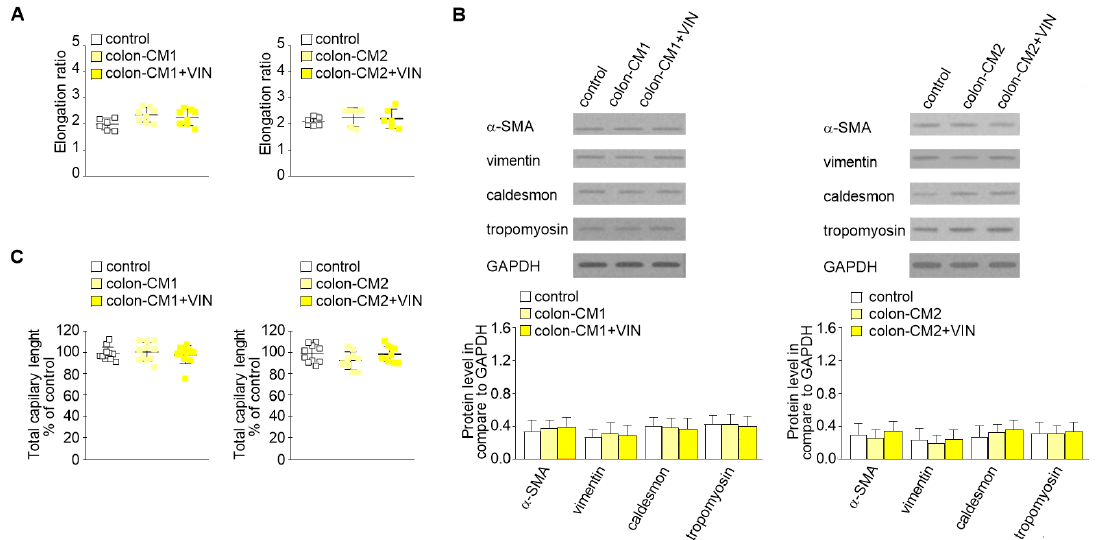
Figure 3. Mesenchymal transdifferentiation in HMEC-1 is not induced by CM from colon cancer cells treated with vincristine. HMEC-1 cells were cultured in medium supplemented with CM isolated from colon cancer cell lines maintained in CM CAFs and treated, if necessary, with vincristine (+VIN). Then, elongation ratio ( n = 6) ( A ), level of contraction proteins (caldesmon, tropomyosin), vimentin, and α-SMA (Western blot) ( B ), and capillary assay ( n = 9) ( C ) were analyzed. In the Western blot assay, GAPDH was used as the loading control. The results are provided as means ± SD ( n = 3). The blots are representative of three independent experiments.